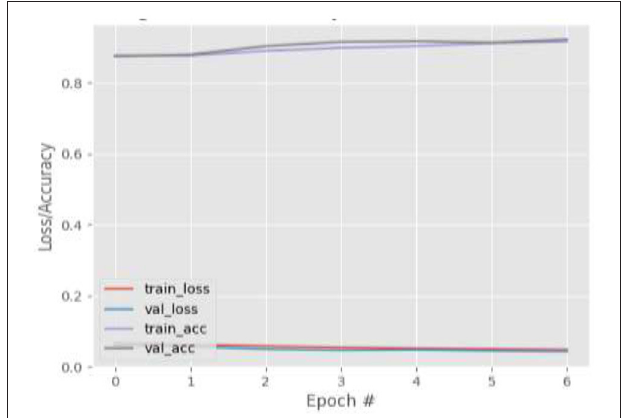
FIGURE 6 | Results for FL only (39-points facial landmarks) on GazeCapture dataset.